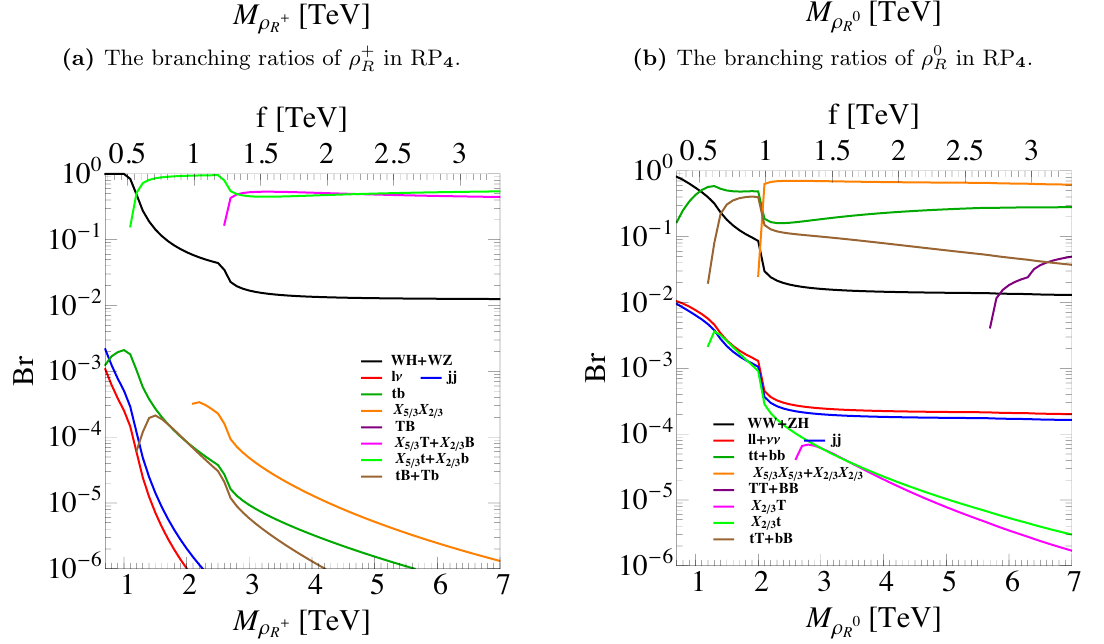
in RF 4 . R resonances. The parameters are g (cid:26) R